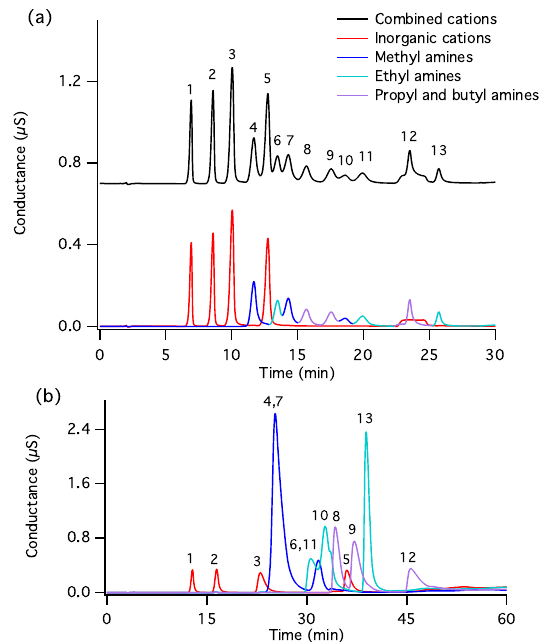
Figure 3. (a) Separation of amine and inorganic cation standards with the addition of MPAH + , iMPAH + , and MBAH + using the final gradient program. The order of elution and mass of cation injected in (a) is as follows: Li + (1, 1.6ng), Na + (2, 16ng), NH + (3, 17ng), MMAH + (4, 50ng), K + (5, 52ng), MEAH + 4 (6, 50ng), DMAH + (7, 50ng), iMPAH + (8, 50ng), MPAH + (9, 50ng), TMAH + (10, 50ng), DEAH + (11, 50ng), MBAH + (12, 50ng), and TEAH + (13, 50ng). (b) Separation of amine and in- organic cation standards with the addition of MPAH + , iMPAH + , and MBAH + and the addition of the CG15 column using a modi- fied gradient program. Cation peaks are labelled accordingly to the same identities in (b) and the mass of analyte injected is as follows: Li + (1.6ng), Na + (16ng), NH + (17ng), MMAH + (500ng), K + 4 (52ng), MEAH + (500ng), DMAH + (500ng), iMPAH + (500ng), MPAH + (500ng), TMAH + (500ng), DEAH + (500ng), MBAH + (500ng), and TEAH +